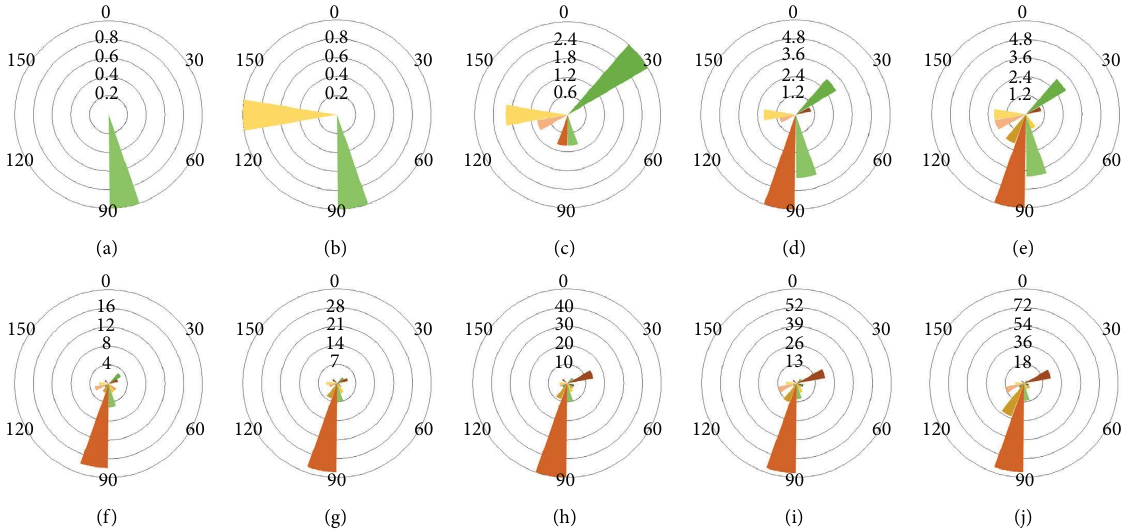
Figure 11: Evolution characteristics of the rock crack azimuth of the ultrasonic vibration assisting disc cutter: (a)–(j) crack azimuth distribution at 10 sampling points.